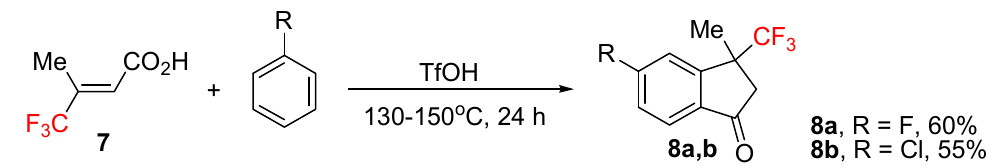
Scheme 5. Reaction of 3-CF 3 -crotonic acid 7 with arenes in neat TfOH, resulting in CF 3 -indanones 8a,b . Similar cyclization of enantiomeric CF 3 -acid 9 into indanone 10 in TfOH has been de- scribed in work [24] (Scheme 6). The starting compound 9 was obtained by rhodium(I)- catalyzed asymmetric hydrogenation of the corresponding β -CF 3 -substituted acrylic acid.